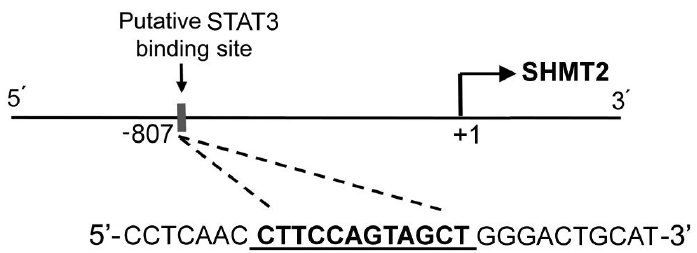
Figure 3. Sequences and positions of putative STAT3-binding elements on the 5 ′ -flanking region of the SHMT2 gene.